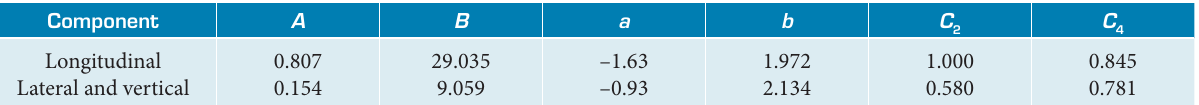
C 2 4 0.807 29.035 –1.63 1.972 1.000 0.845 0.154 9.059 –0.93 2.134 0.580 0.781